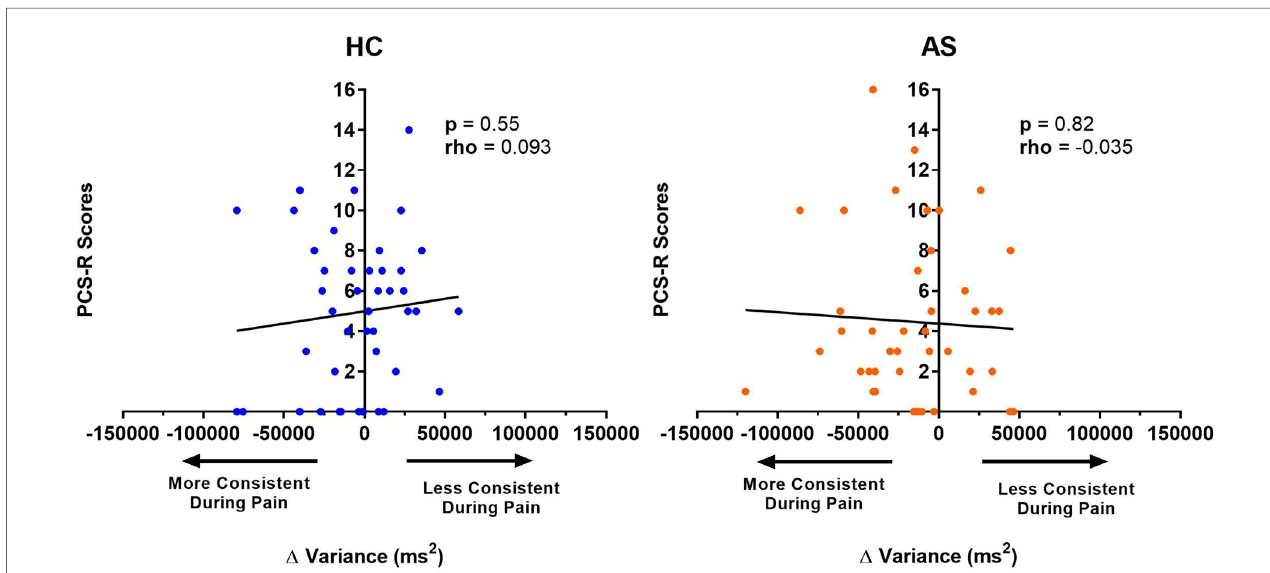
FIGURE 9 Relationship between an individual ’ s pain rumination score and the effect of pain on their variance in task reaction time (RTv). No signi fi cant correlation was found between the pain rumination scores (derived from the rumination subscale of the pain catastrophizing scale) (PCS-R) and the Δ RTv in the healthy controls (HCs) or for the ankylosing spondylitis (AS) group. The HCs are represented by the blue dots. The AS group is represented by the orange dots. More consistent RTs during pain is represented by a negative Δ RTv value (values that are on the left side of the horizontal axis). Less consistent RTs during pain is represented by a positive Δ RTv value (values that are on the right side of the horizontal